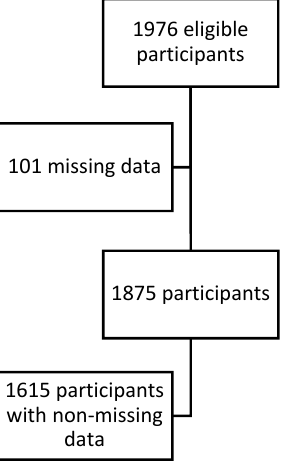
Figure 1. A flowchart of the number of participants. Table 1. Baseline Demographics. In total, 735 participants (45.4%) of the study population had no natural teeth. Just over a third of the participants (35%; n = 580) had a functional dentition. Approximately 50% ( n = 822) of the population brushed their teeth/dentures at least once a day and 124 (7.9%) reported brushing their teeth/dentures more than two times a day (Table 2). More than 40% ( n = 661) had at least one set of posterior occlusal pairs, and of the dentate indi- viduals with at least one missing tooth, just over 82% ( n = 663) had no dentures (Table 2). For dentate individuals, 32.3% ( n = 274) had all four maxillary anterior teeth missing (Ta- ble 3). Table 2. The distribution of OIDP according to various clinical outcomes.